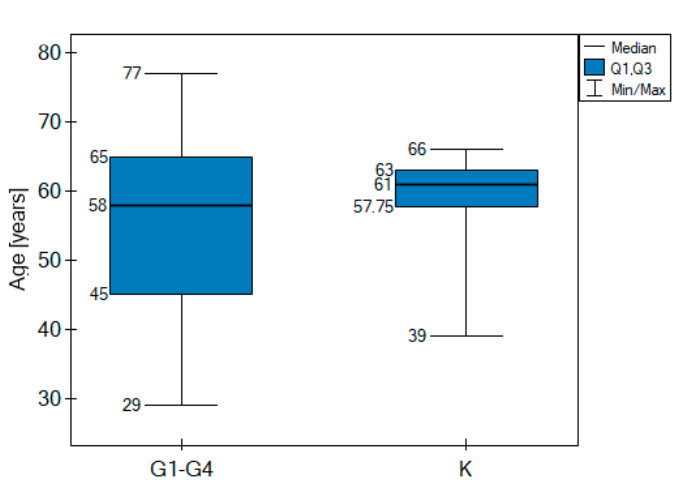
Figure A1. Age-related analysis of the patient group and the control group.